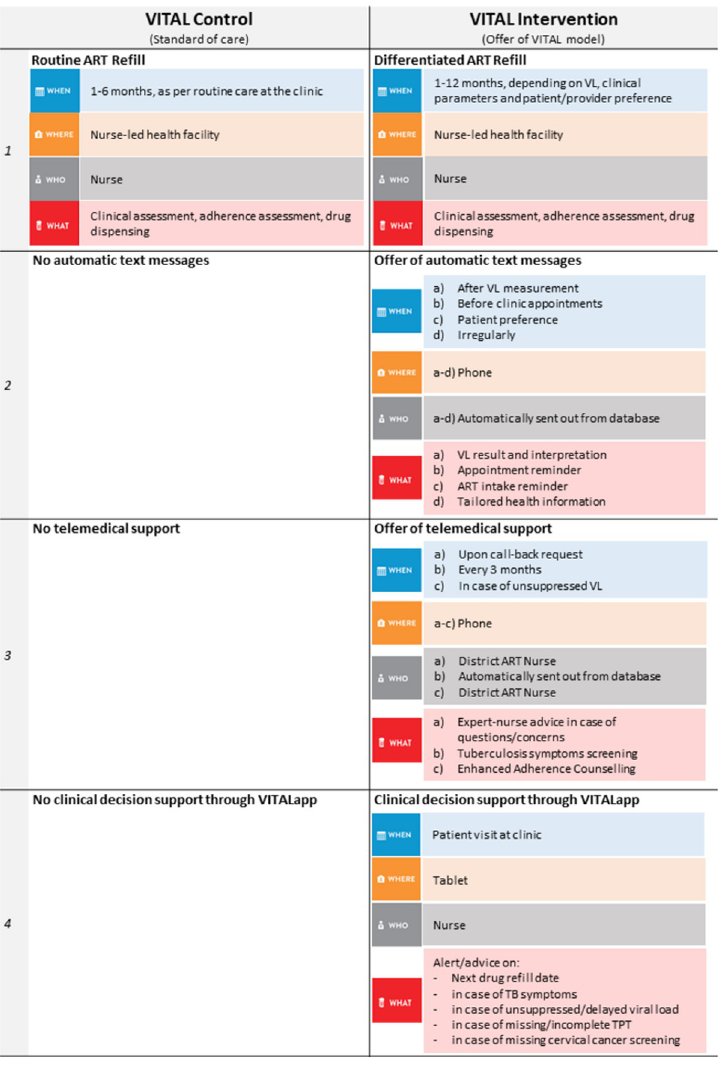
Fig 3. Differentiated service delivery building blocks of the VITAL model. VL: Viral load; TB: Tuberculosis; TPT: Tuberculosis preventive therapy; ART: Antiretroviral